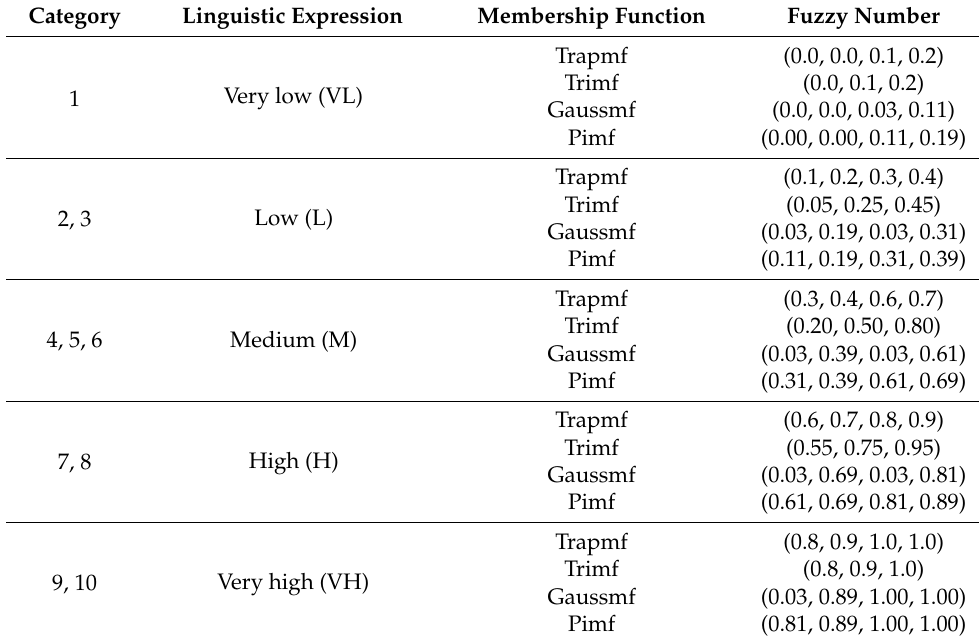
Table 4. 5-scale fuzzy number with 4 membership functions.